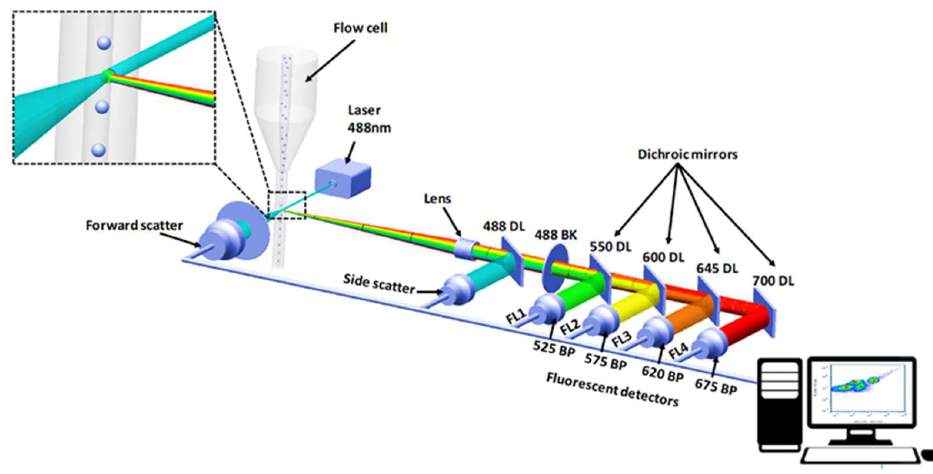
Figure 1. Filter configuration used in the commercial flow cytometer.